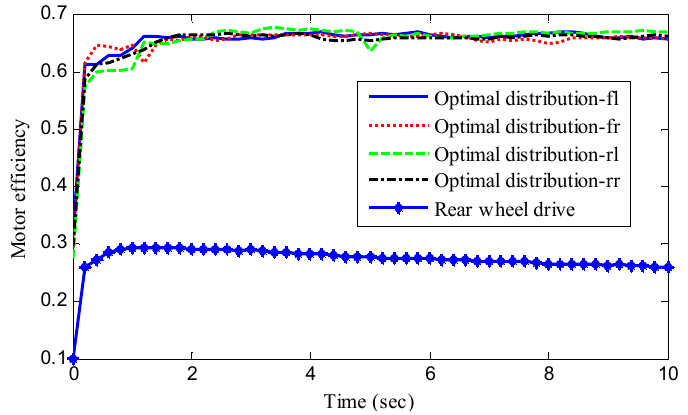
Figure 16. Motor efficiency in case study 2. World Electric Vehicle Journal 2019 , 10 , 15